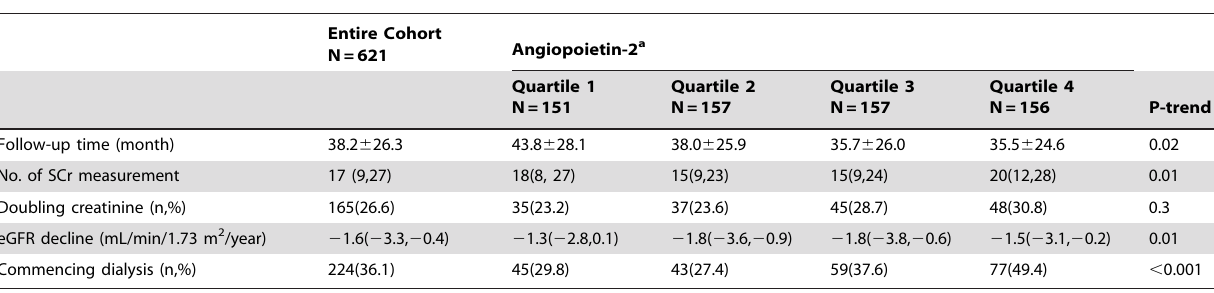
Table 2. Renal outcome of all subjects stratified by Angiopoietin-2 quartile.